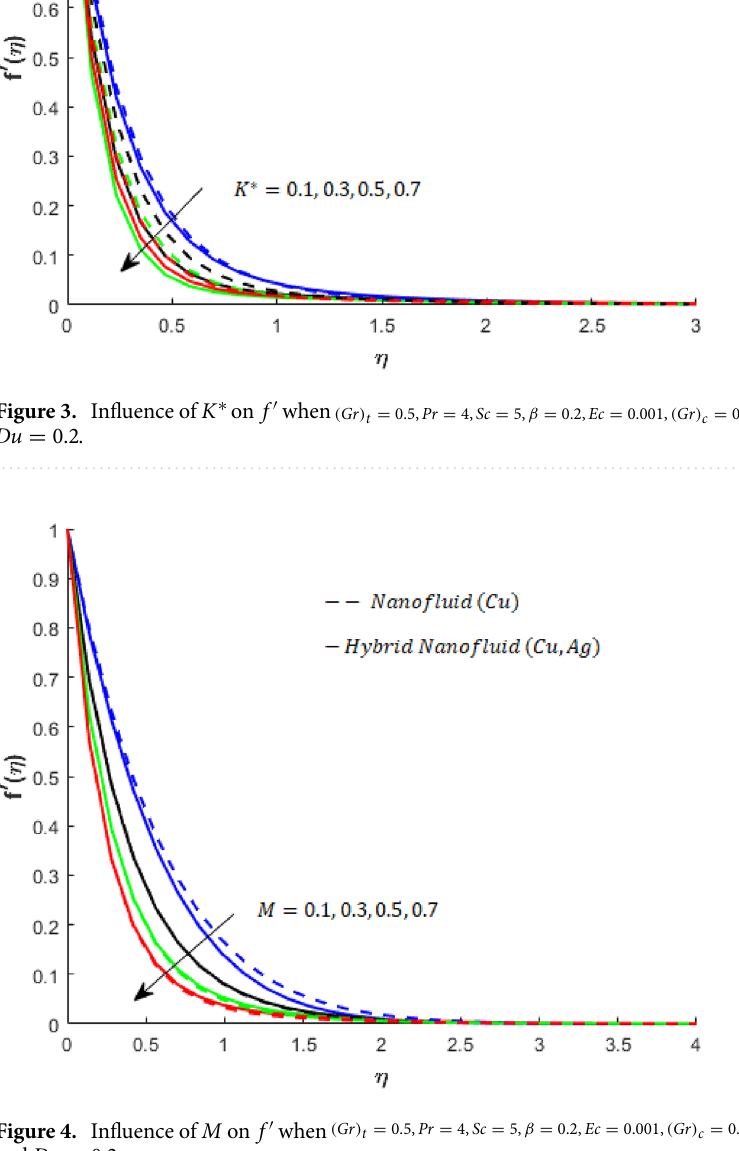
Figure 4. Influence of M on f ′ when ( Gr ) t = 0.5, Pr = 4, Sc = 5, β = 0.2, Ec = 0.001, ( Gr ) c = 0.3, K ∗ = 0.1, β ∗ = 0.2, Sr = 0.1, and Du =